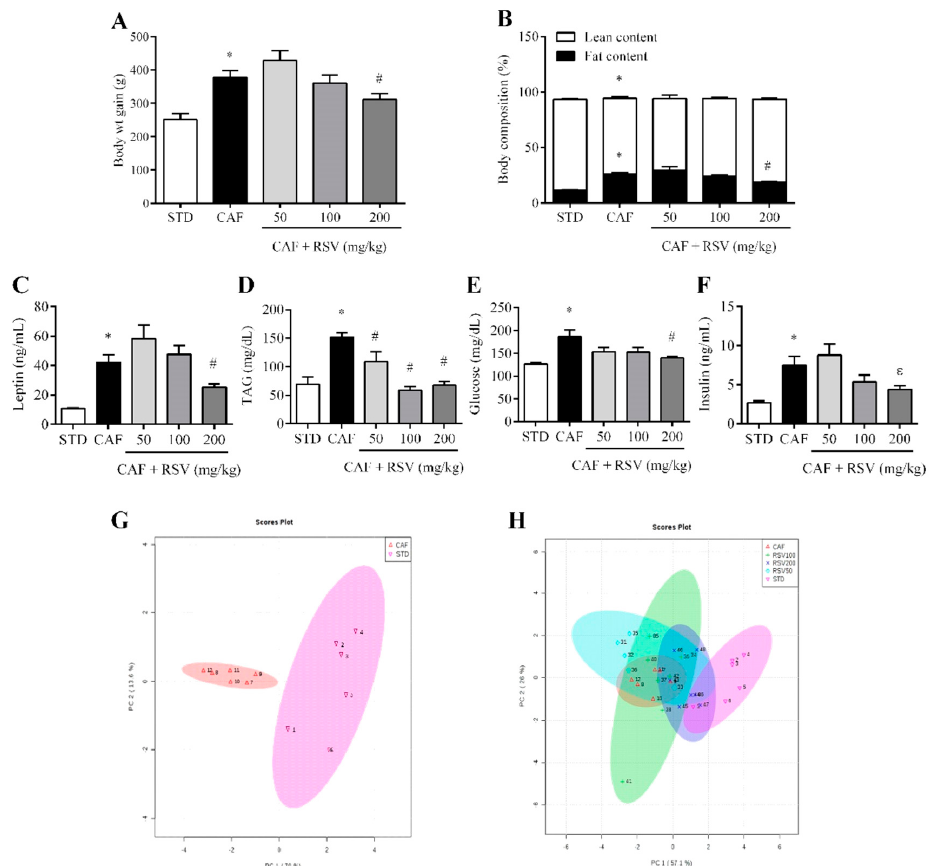
Figure 1. Metabolic parameters. The rats were fed the STD or CAF diet for 9 weeks. Then, the rats in the STD and CAF groups were treated orally with RSV (50, 100 or 200 mg per kg of body weight) or vehicle for 3 weeks. ( A ) Body weight gain (g) from the first day of the experiment until the last day; ( B ) Body composition (%) assessed by NMR, including fat and lean content; Serological levels of ( C ) leptin, ( D ) TAG, ( E ) glucose and ( F ) insulin. ( G ) and ( H ) are PCAs representing the clusters between